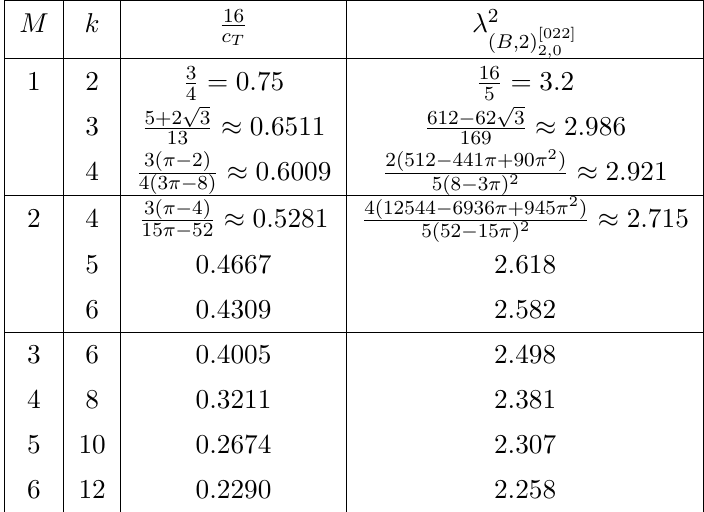
Table 7 . OPE coefficients 16